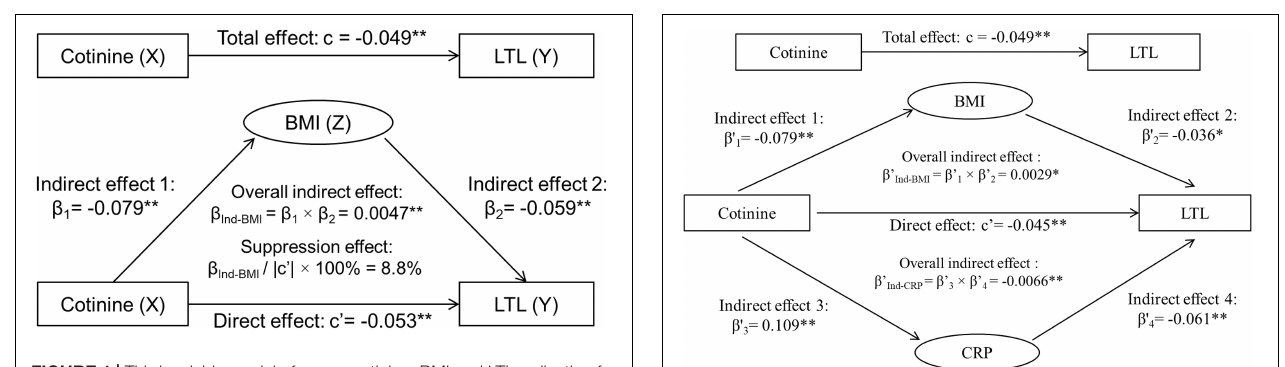
FIGURE 1 | Third variable model of serum cotinine, BMI and LTL, adjusting for age, race, sex, physical activity, and alcohol drinking. β , c and c’ are standardized regression coefficients. c, total effect; c’, direct effect; β 1 , indirect effect 1; β 2 , indirect effect 2; β Ind − BMI , overall indirect effect; BMI, body mass index; LTL, leukocyte telomere length. ** p < 0.01 for β , c, and c’ being different from 0. In the case of |c| > | β Ind − BMI |: Total effect (c) = Direct effect (c’) + Indirect effect ( β Ind − BMI ). − 0.0486 = − 0.0533 + 0.0047, |c| < |c’|, then β